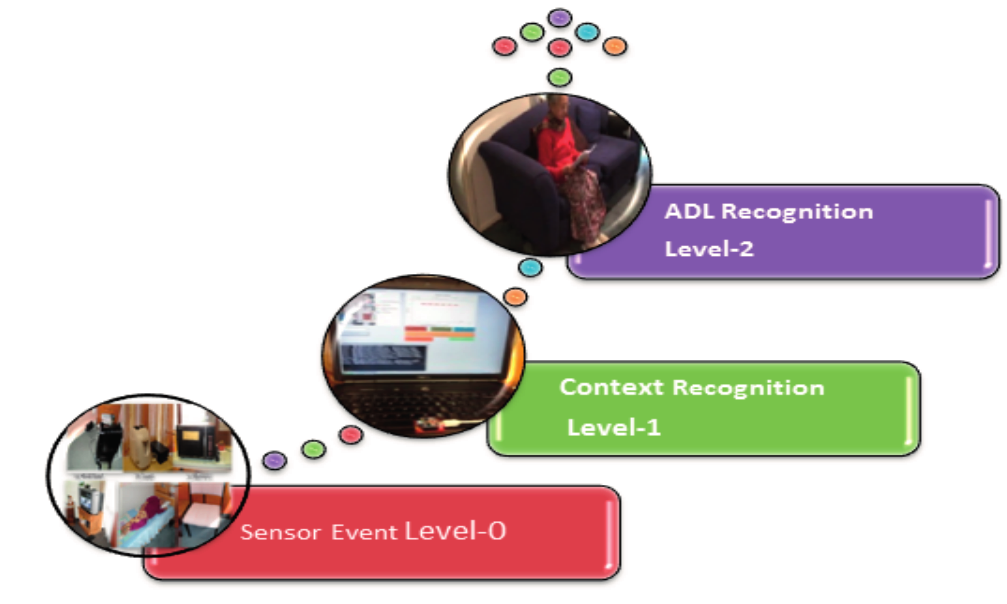
Figure 7. Activity recognition divided into three different levels